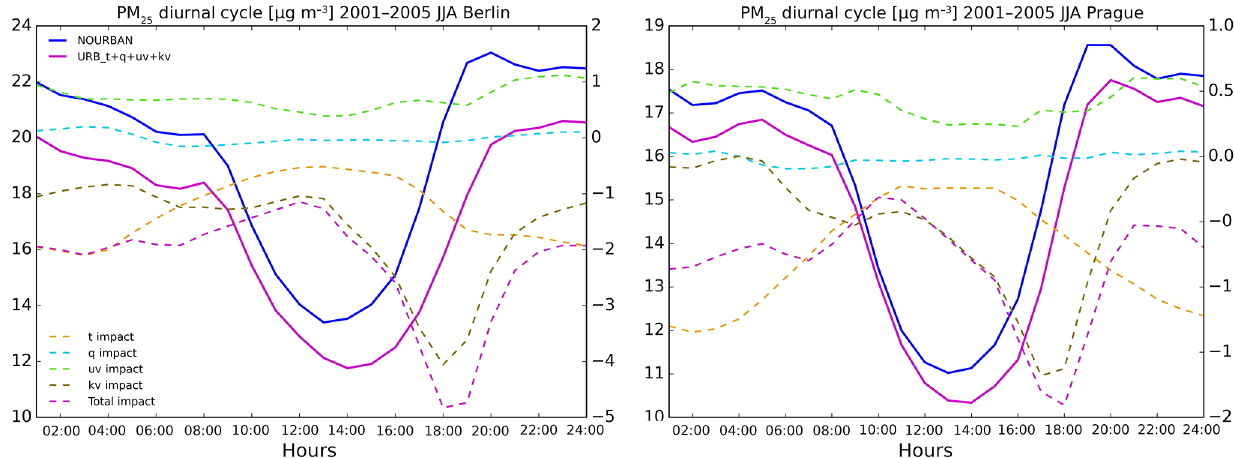
Figure 5. Impact of urban canopy meteorological forcing on PM 2 . 5 average diurnal cycle of surface concentrations for the 2001–2005 JJA period for two selected cities (Berlin and Prague) in µgm − 3 . Bold lines represent the absolute concentrations (left y axis) for the NOURBAN run (blue) and the total impact URB_t+q+uv+Kv run (purple). Dashed lines (right y axis) show the change due to changes of individual